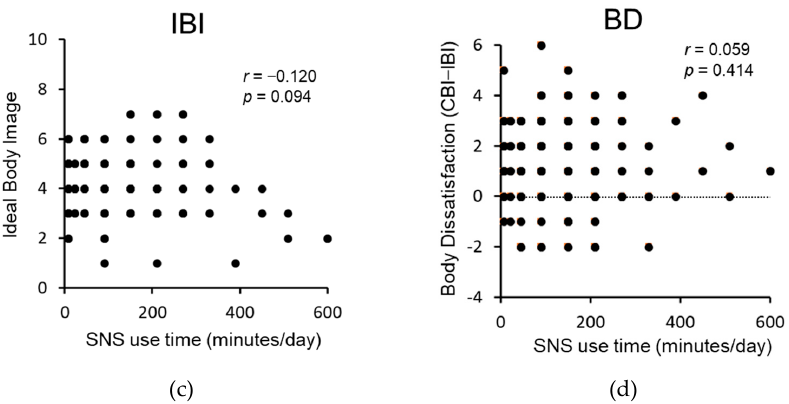
Figure 1. Correlations between the duration of SNS use and ( a ) body mass index, ( b ) current body image, ( c ) ideal body image, and ( d ) body dissatisfaction (all n = 196). Spearman’s correlation. Body dissatisfaction was calculated as the difference between current and ideal body image. SNS = social networking